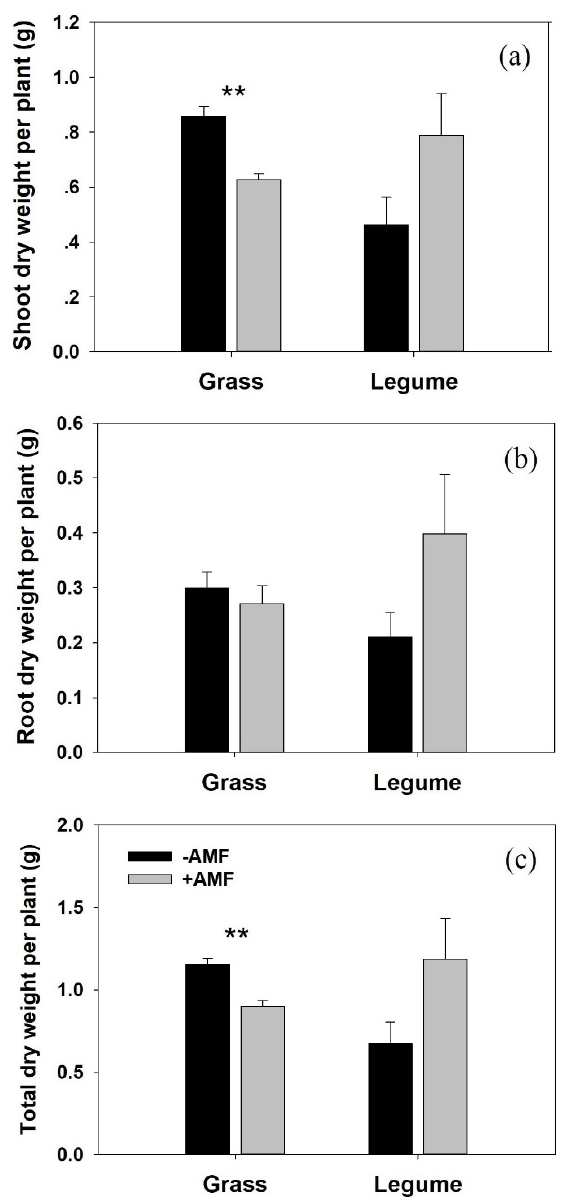
Figure 2. Shoot dry weight (DW), root DW, and total DW of Pedicularis kansuensis ( a – c ). Data are presented as the mean ± standard error. There are seven replicates for the nonmycorrhizal grass-hemiparasite association, five replicates for the nonmycorrizal legume-hemiparasite association, and four replicates for the mycorrizal grass-hemiparasite and legume-hemiparasite associations. Grass: Elymus nutans ; Legume: Trifolium repens . Significant differences (as determined by t -test) between mycorrhizal (gray bars) and non-mycorrhizal (black bars) treatments are indicated by asterisks (** p < 0.01). Biomass data of P. kansuensis were taken from Sui et al. [30].